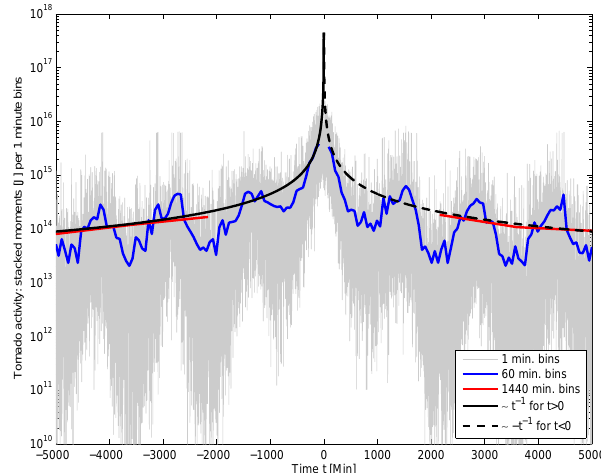
Fig. 6. Omori-like behaviour in tornado activity following and pro- ceeding a tornado event with atmospheric moments of at least M ≥ 10 10 J, a stacking method of tornado moments is used (USA tornado data, 1950–2006). Grey, blue and red lines represent the 1min, 60min and 1440min bins, respectively. Black solid and black dashed line are fitted to the fore- and aftershock sequences follow- ing power laws proportional to f fore (t) ∼ − t − 1 and f after (t) ∼ t − 1 , respectively ( t : time).